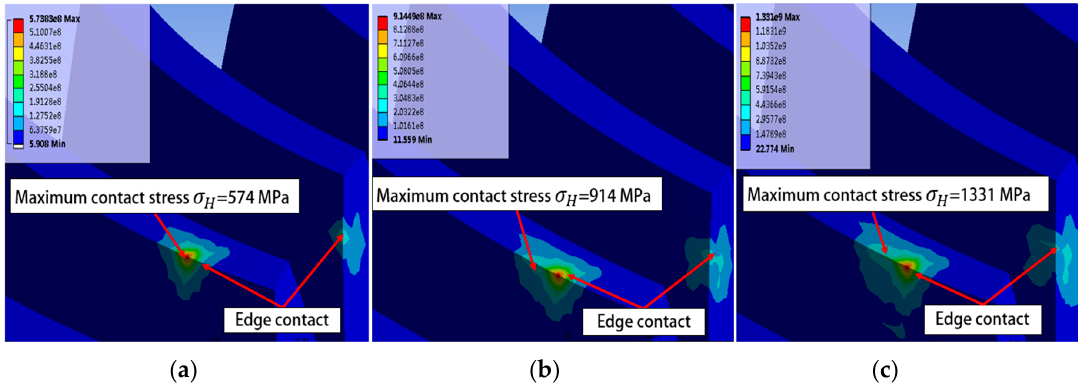
Figure 11. Comparison of loaded contact stress of the gear convex face: ( a ) Load T = 1500 Nm, ( b ) Load T = 4500 Nm, and ( c ) Load T = 7500 Nm.